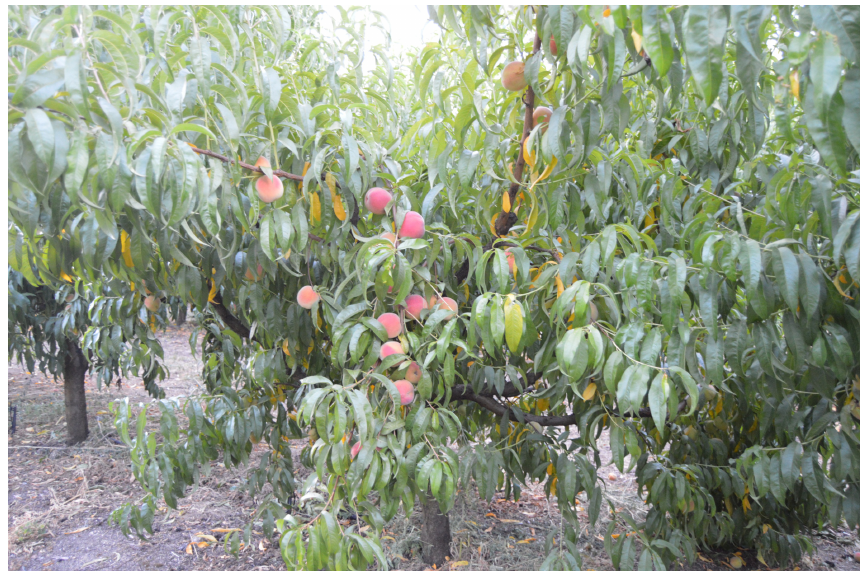
Figure 4. Testing sample image.